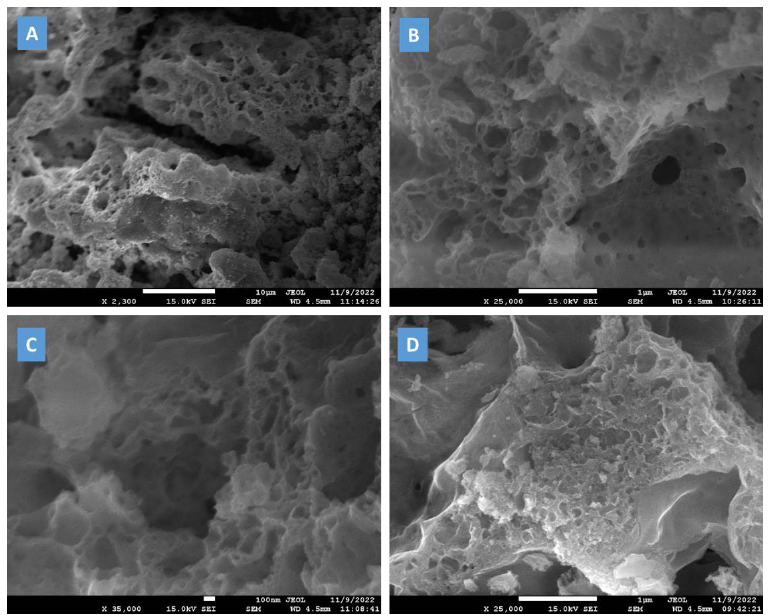
Figure 4. SEM micrographs of Mn-doped porous ceria samples. ( A ) Mn-CeO 2 (1%), ( B ) Mn- CeO 2 (2.5%), ( C ) Mn-CeO 2 (5%), and ( D ) Mn-CeO 2 (10%).